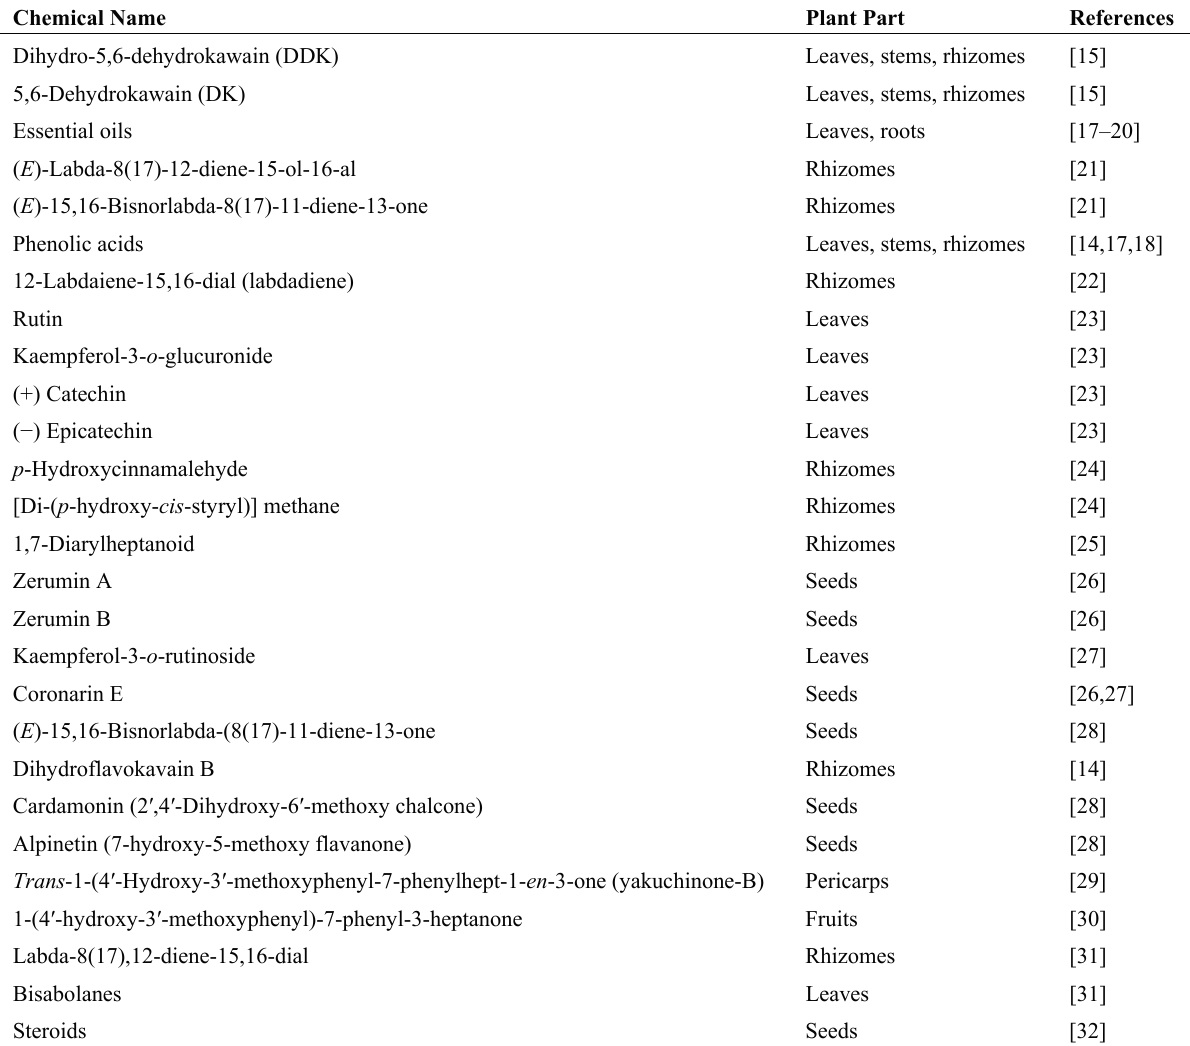
Table 1. DDK, DK, and other chemicals in various plant parts of Alpinia zerumbet .